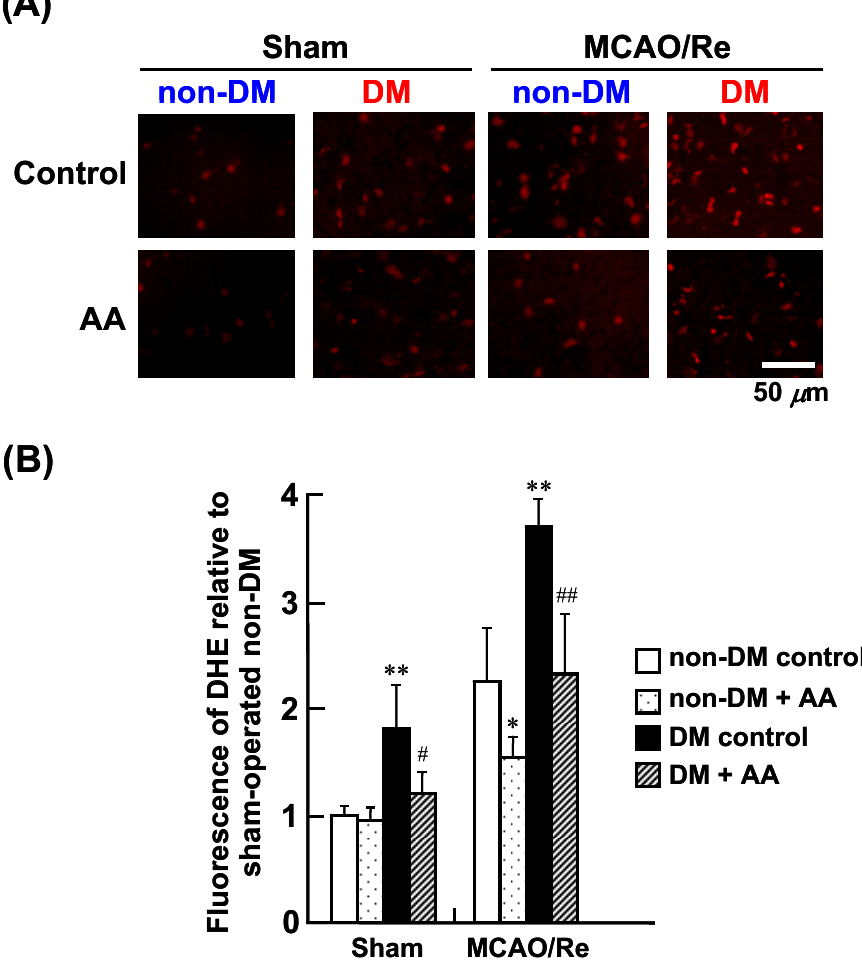
Figure 3. Effects of AA supplementation on production of O 2– after MCAO/Re in the brain of nondiabetic and diabetic rats. ( A ) Representative photographs of superoxide production detected by DHE staining in coronal sections of the cortex from the nondiabetic and diabetic rats; ( B ) Quantitative analysis of DHE fluorescence intensity in the cortex. The data are presented as mean ± SD ( n = 3–4). * p < 0.05, ** p < 0.01 compared with the nondiabetic control group. # p < 0.05, ## p < 0.01 compared with the diabetic control group. DM in the figure denotes diabetic, while non-DM denotes